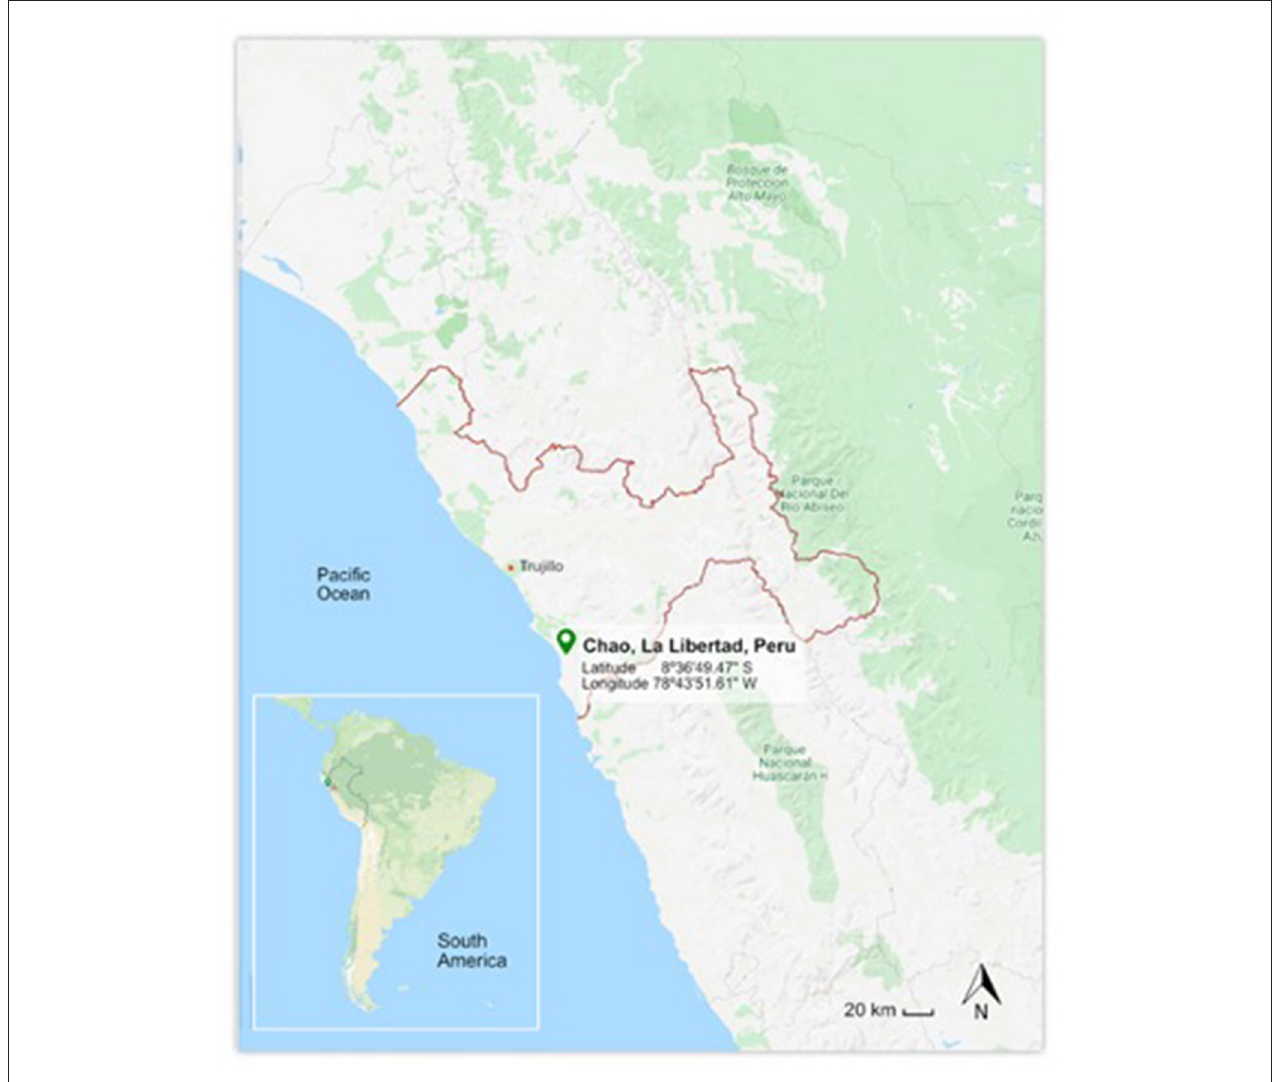
FIGURE 1 | Crops where the dried fruits of Caesalpinia spinosa were collected, on December 5, 2020.